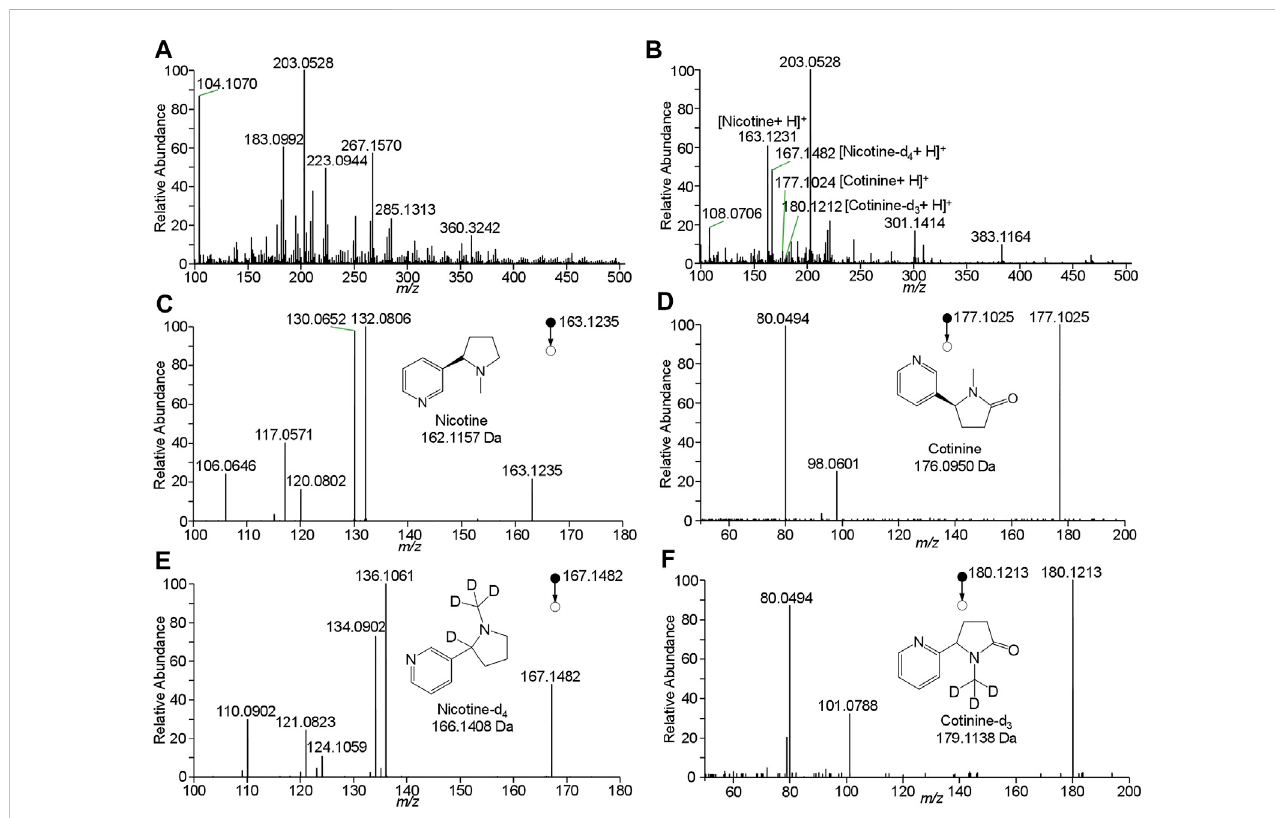
FIGURE 4 WTS-MS detection ofnicotine and cotinine inmeconium: (A) blank meconium, (B) meconium spiked withnicotineand cotinine, (C) MS/MS spectrum of nicotine, (D) MS/MS spectrum of cotinine, (E) MS/MS spectrum of nicotine-d4, (F) MS/MS spectrum of cotinine-d3.